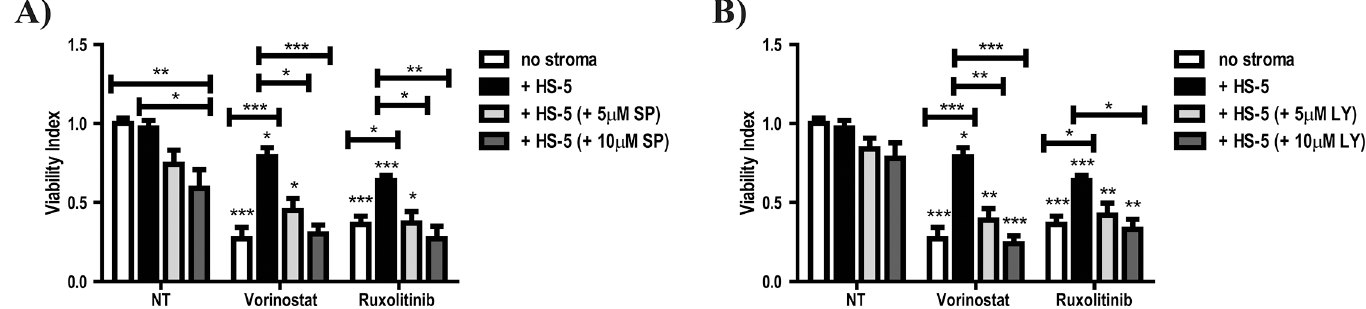
Fig 3. Pharmacological inhibition of JNK and PI3K signalling pathways completely reverted HS-5 BM stroma mediated protection of SET-2 cells. (A and B) SET-2 cells were cultured invitro (no stroma) and co-cultured in a stromal layer of HS-5 cells (+ HS-5) for 72h in the presence of 2.0 μ M Vorinostat (Vor.), 500nM Ruxolitinib (Rux.), 5 μ M and 10 μ M SP600125 (JNK inhibitor) (in A) and 5 μ M and 10 μ M LY294002 (PI3K inhibitor) (in B). After 72h, the SET-2 cells were harvested, stained with CD45 (to distinguish between SET-2 and the stromal cell lines) and Annexin-V/PI or PI alone to determine cellular viability by Flow Cytometry analysis as described in “ Materials and Methods ” . The panels in (A and B) show the Viability Index graphs that normalize the viability values to those of the control condition (non-treated condition NT). Values indicate the mean ± standard deviation of the five experiments performed ( * 0.05 > p; ** 0.01 > p; *** 0.001 >